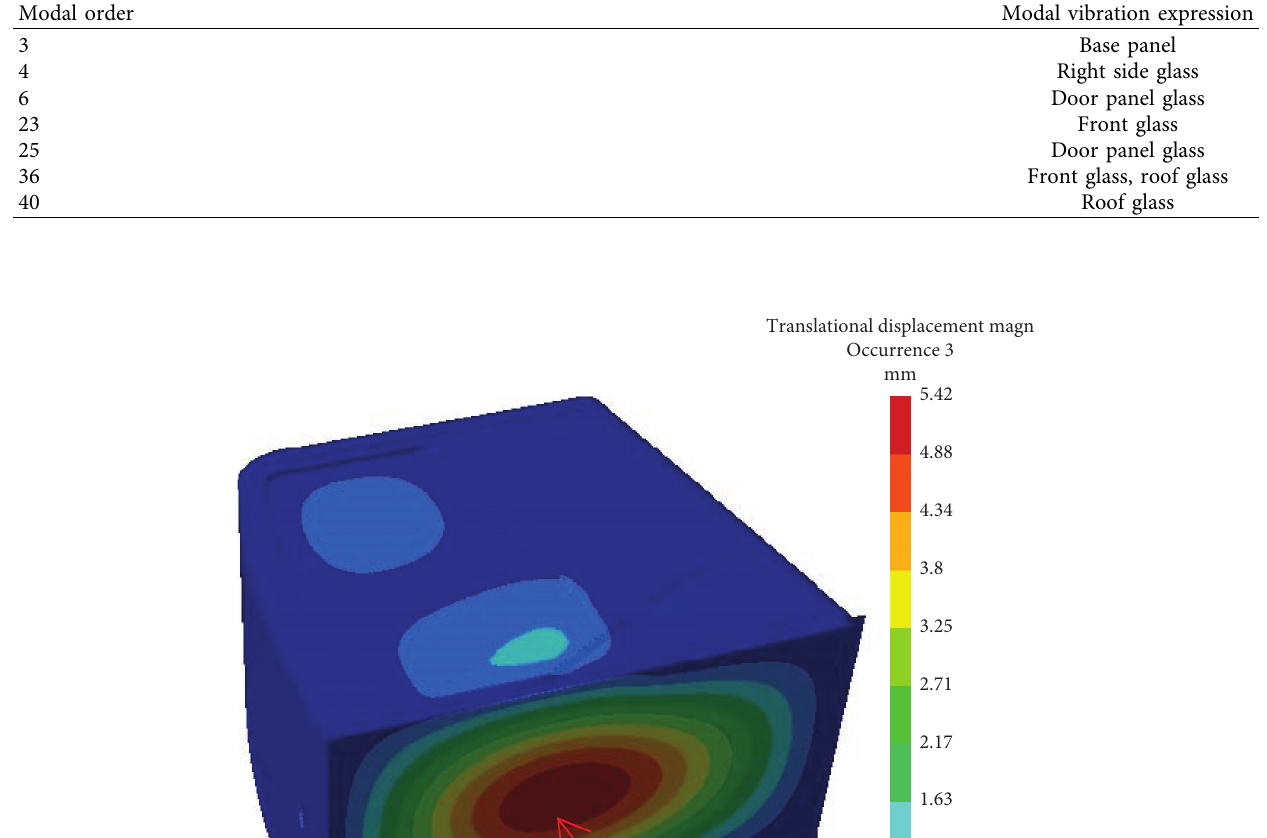
Figure 14: Modal contribution of the cab at 100 Hz. Table 2: Manifestation of the relevant mode vibration pattern.